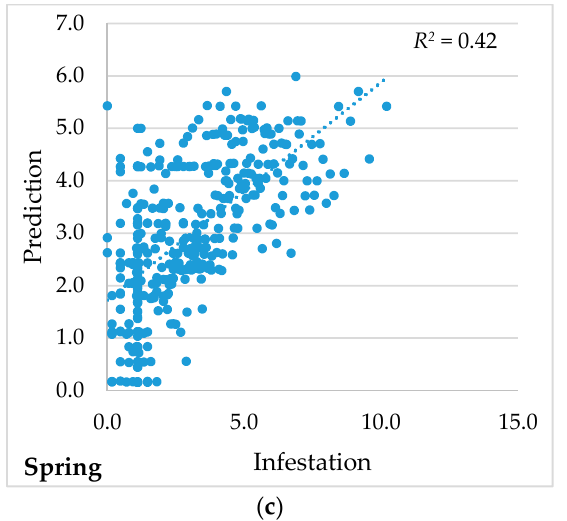
Figure 3. Scatter plot for the OLS (ordinary least regression) regression model of the significant environmental factors for four seasons ( a ), autumn ( b ) and spring means ( c ).